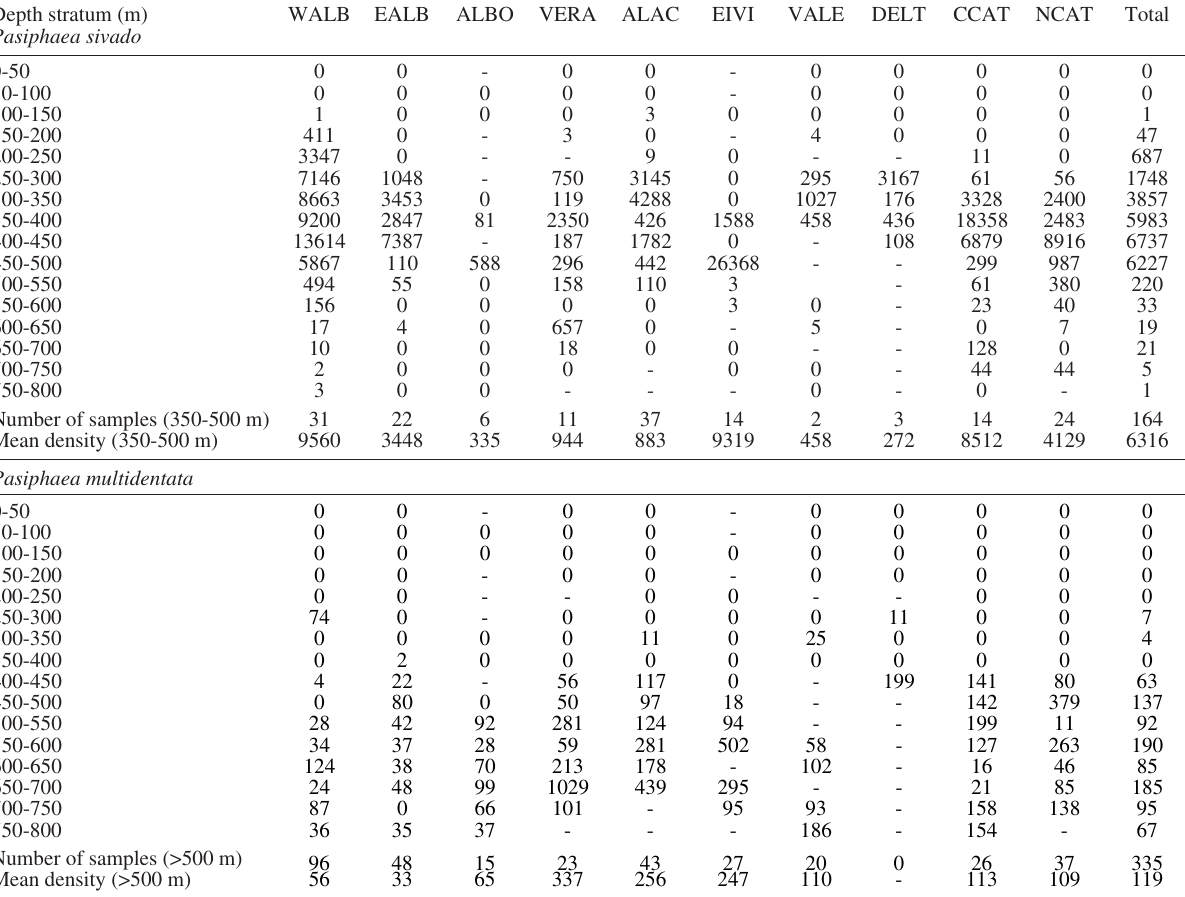
Table 2. – Mean density (ind. km –2 ) of Pasiphaea sivado and Pasiphaea multidentata within each depth stratum and geographic sector along the Iberian Peninsula Mediterranean coast. Mean density per geographic sector corresponds to densities within the 350-500 m depth strata for P. sivado and >500 m for P. multidentata (i.e. those with the overall highest frequency of